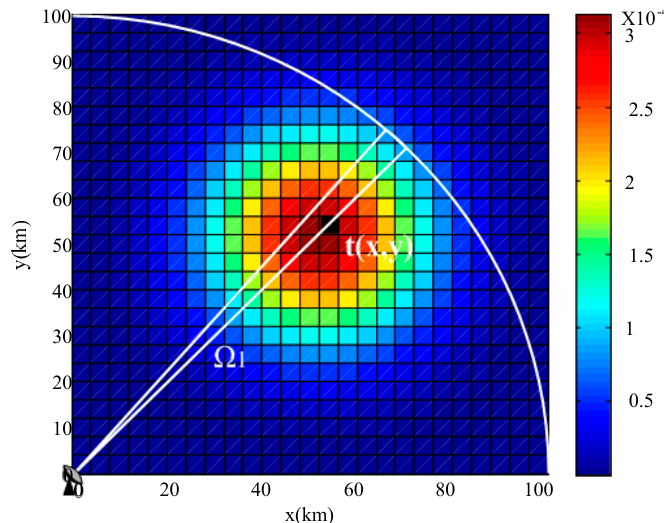
Figure 3. The domain covered by beam a and the position distribution of target t .